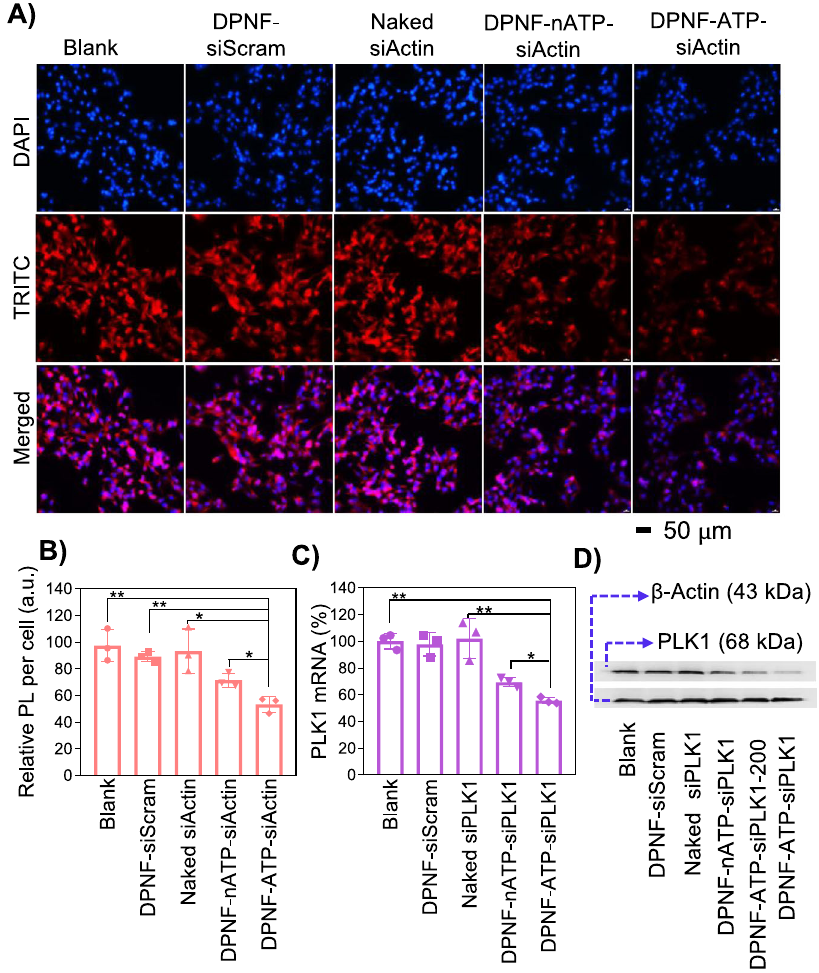
Fig. 6 Gene silencing of siRNA-loaded DPNF-20 in vitro. A Gene silencing effects of siActin-loaded DPNF-20 in MBA-MD-231 cells. MBA-MD-231 cells were treated, respectively, with naked siActin, DPNF-siScram, DPNF-nATP-siActin, and DPNF-ATP-siActin at same dose for 6 h. After 48 h, the cellular actin cytoskeletons were stained with phalloidin-TRITC and observed with fl uorescence microscope. The siActin was 300 nM, and the DPNF was 420 μ g/ ml. B Quantitative analysis of gene silencing effects of siActin in different formulations in ( A ). Error bars represent s.d. ( n = 3 replicates), * p < 0.05, ** p < 0.01. C , D Gene silencing effect of siPLK1-loaded DPNF-20 in MBA-MD-231 cells. C MBA-MD-231 cells were treated, respectively, with naked